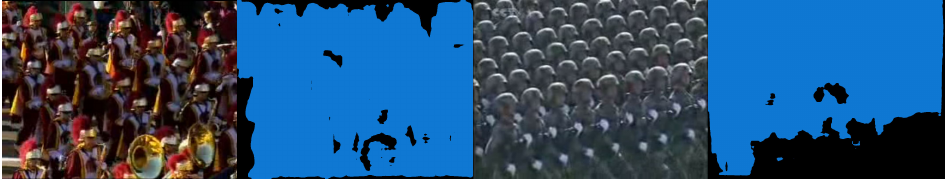
Figure 7. Examples of failure cases from the the UCF101 dataset. The first example is labeled “Marching Band” and the second is labeled “Military Parade”. In both cases, the clutter of same-label objects results in a degenerative blurring